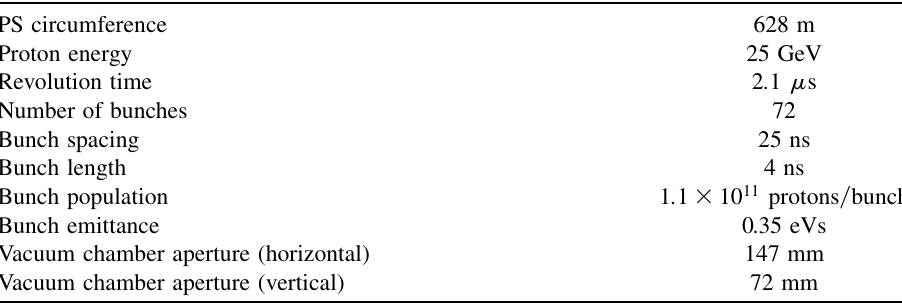
TABLE II. The main machine and beam parameters for the PS electron cloud experiment.